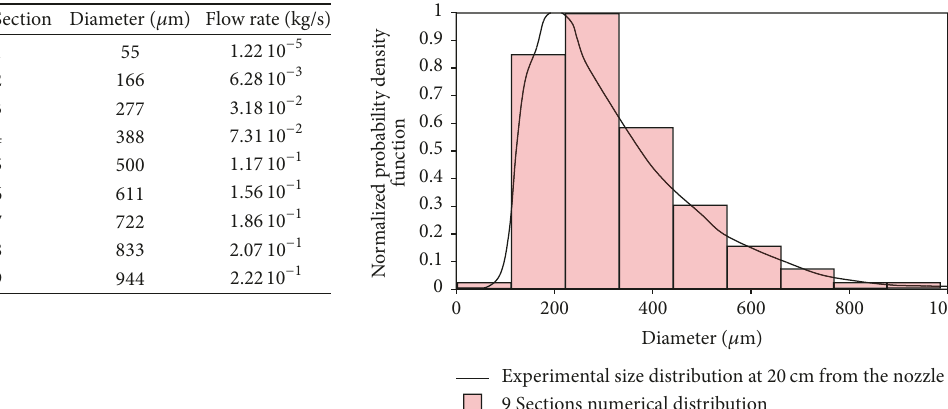
Figure 33: Sections used for the numerical simulation, associated with the experimental size distribution to the location 20 cm from the nozzle.